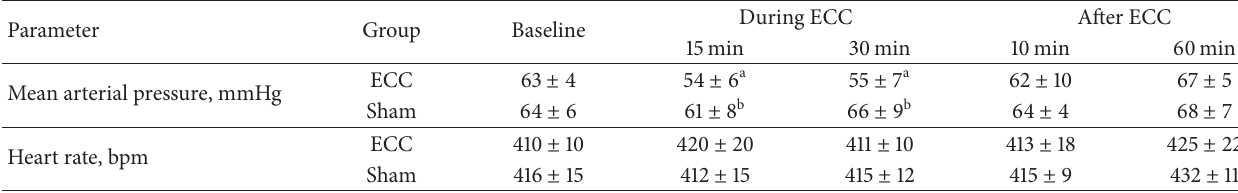
Values reported as mean ± SE. a 𝑃 < 0.05 versus